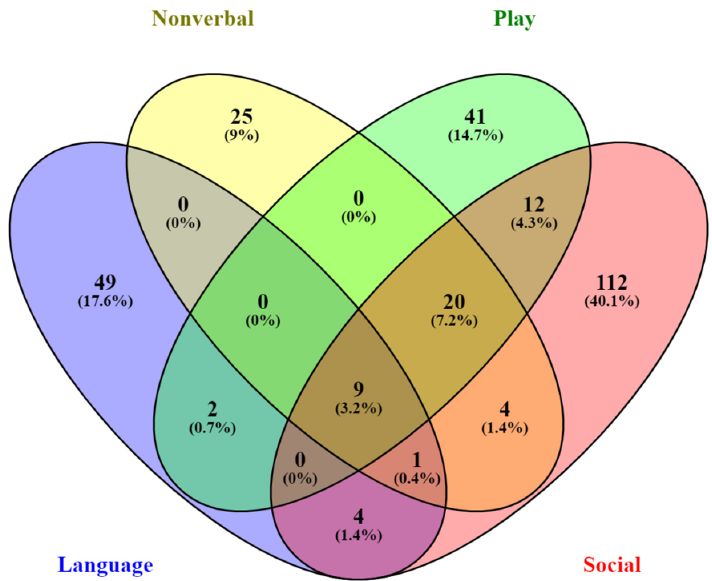
Figure 4. Venn diagram showing SNP-associated gene overlap among language, nonverbal communication, play skills, and social skills. There was no gene overlap between the genes associated with perseverative behaviors and those associated with any of the other four traits.